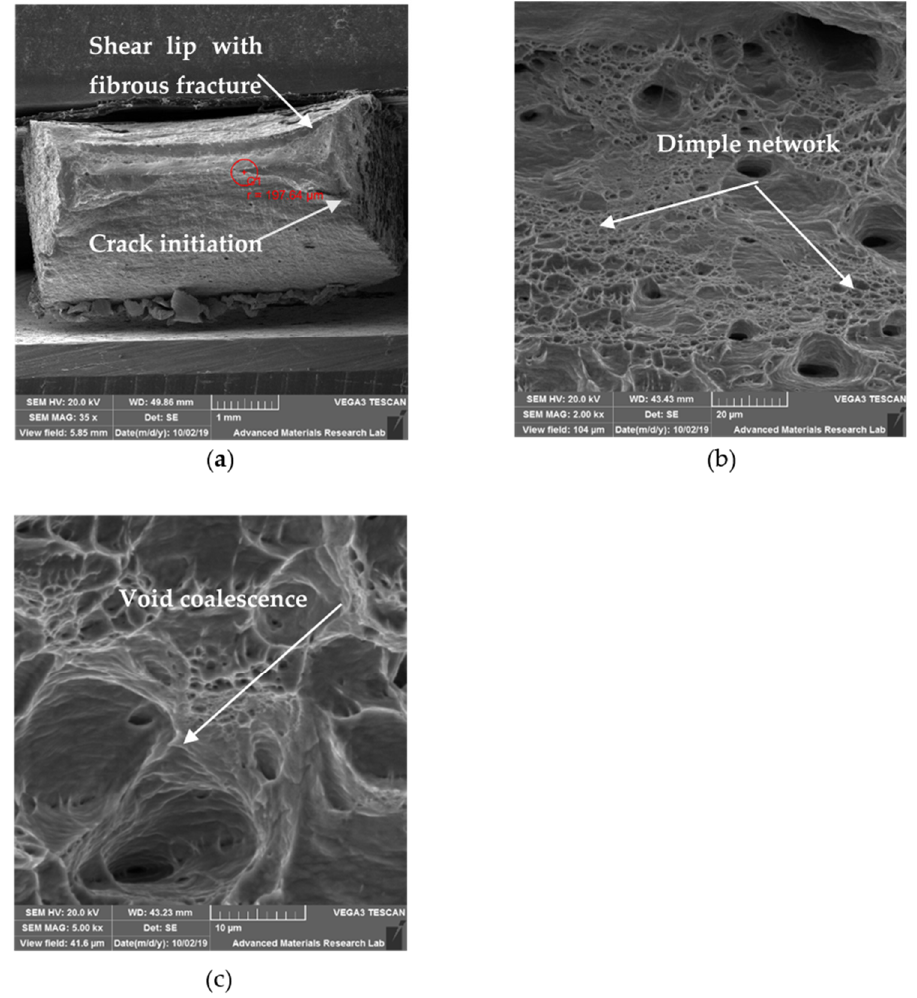
Figure 14. SEM fractography images of HT specimen: ( a ) 35×; ( b ) 2000×; ( c )